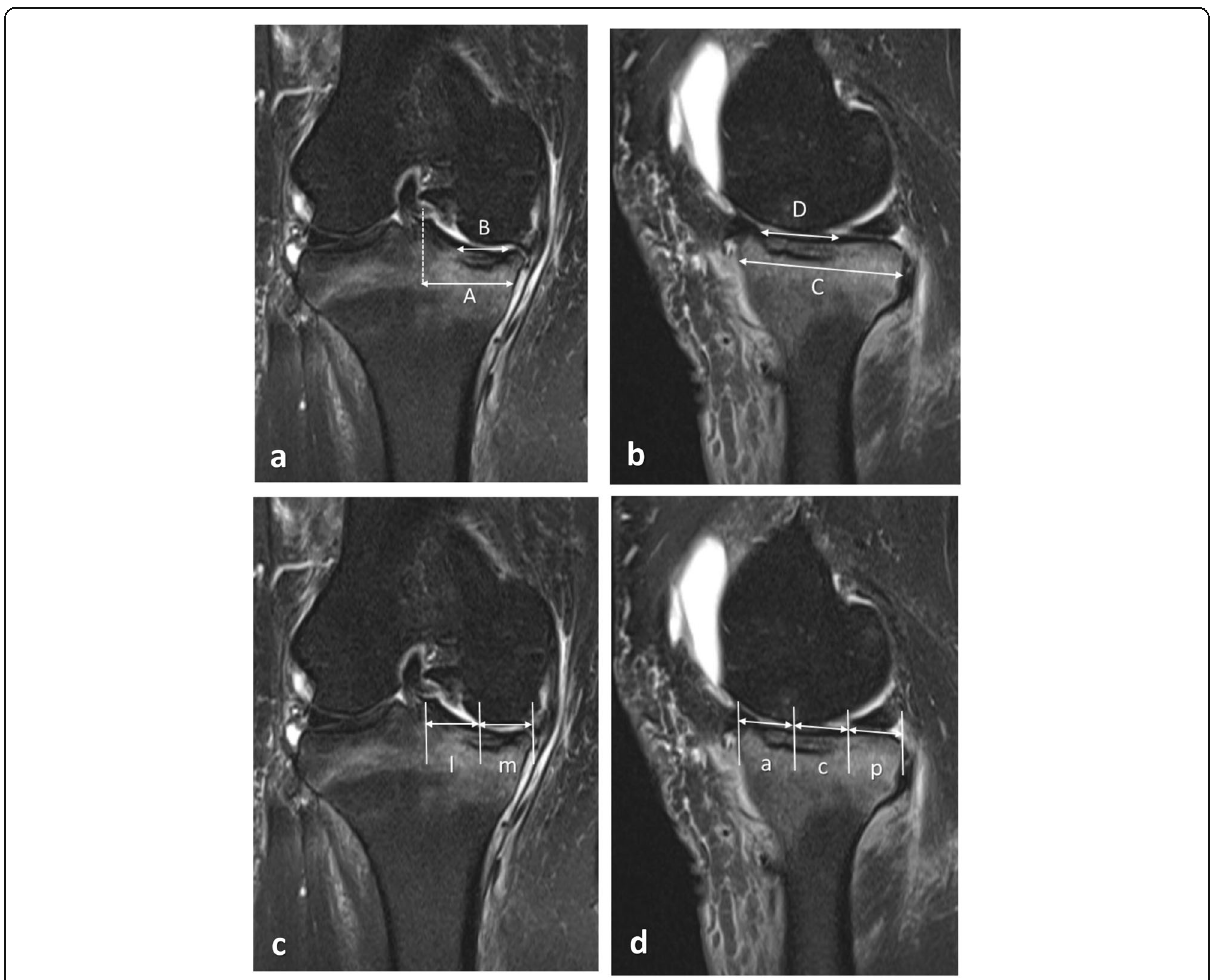
Fig. 1 Evaluations of SONK lesion size and location using magnetic resonance imaging. a, b The size of the necrotic lesion was calculated as the percentage (anteroposterior (AP) = D/C, mediolateral (ML) = B/A) of the AP and ML width of the medial compartment in the sagittal ( b ) and coronal ( a ) planes. The ML width was defined as the distance between the medial intercondylar eminence and the edge of the medial tibial plateau. The AP width was measured on the sagittal plane passing through the center of the ML line. c , d The location of the necrotic lesion was divided into two by bisecting the ML lines in the coronal ( c ) planes. l, lateral; m, medial. In the sagittal (d) plane, the lesion area was also divided into equal anterior ( a ), central ( c ), and posterior (p)